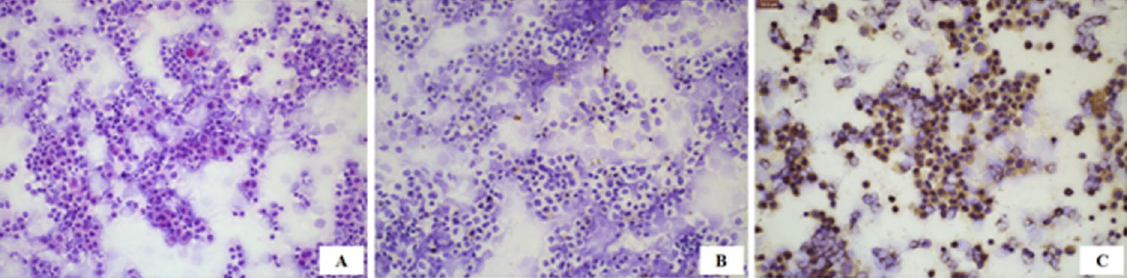
Figure 1. Immunohistochemical staining of GOLPH3 in cumulus granulosa cells. ( A ) HE staining of cumulus granulosa cells, × 20; ( B ) Negative GOLPH3 expression in cumulus granulosa cells with DAB staining and hematoxylin counterstaining, and PBS serves as the primary antibody, × 20; ( C ) Positive GOLPH3 expression in cumulus granulosa cells with DAB staining and hematoxylin counterstaining, × 20.